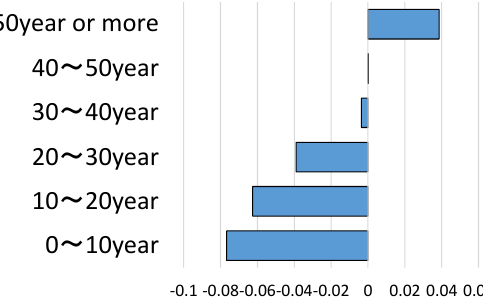
Figure 7. Years in service category scores (slabs).